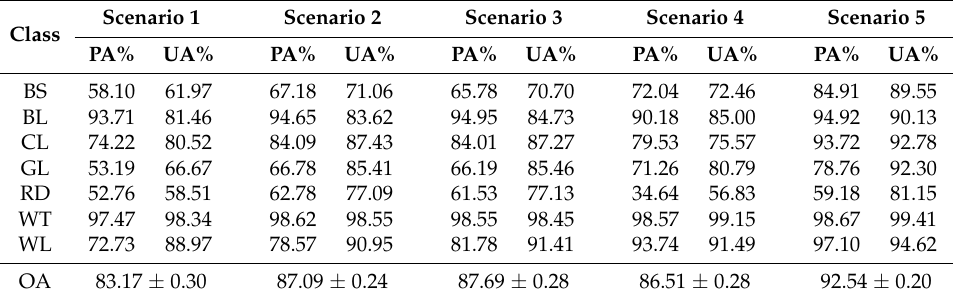
Figure 2. Overall classification accuracies with different input feature scenarios. The red line inside the box represents the median. The bottom and top of the blue boxes are the first and third quartiles. As for the whiskers, the lowest datum represents the lowest value still within 1.5 IQR (IQR = third quartile—first quartile) of the lower quartile, and the hightest datum represents the highest value still within 1.5 IQR of the upper quartile. Red crosses indicated the outliers. Table 3. Averaged PA and UA per land cover class achieved from 30 times by using Random Forests classifier. The input scenarios are derived from SPOT-5 and LiDAR data separately.